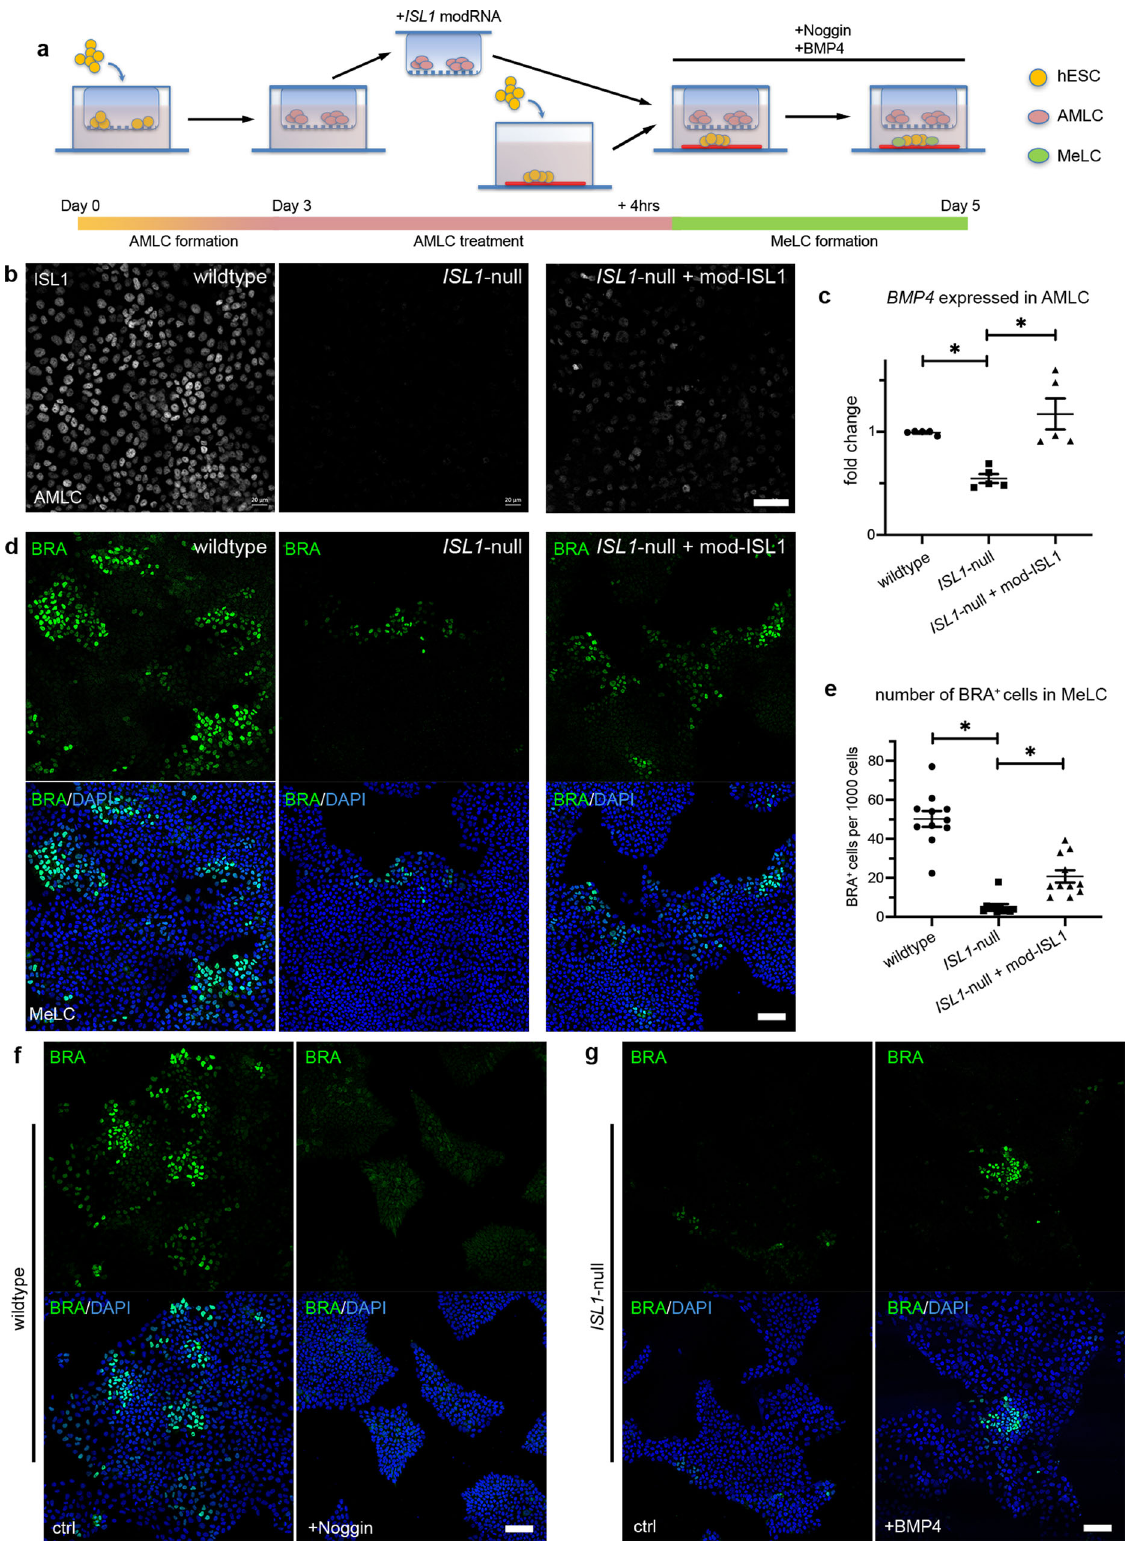
ISL1 -null phenotype. Conversely, external addition of BMP4 in the ISL1 -null led to a partial rescue of the phenotype, shown by a signi fi cant increase in the number of BRA-expressing cells (Fig. 5g and Supplementary Fig. 12b), suggesting that BMP4 signaling is responsible in part for the observed phenotype.